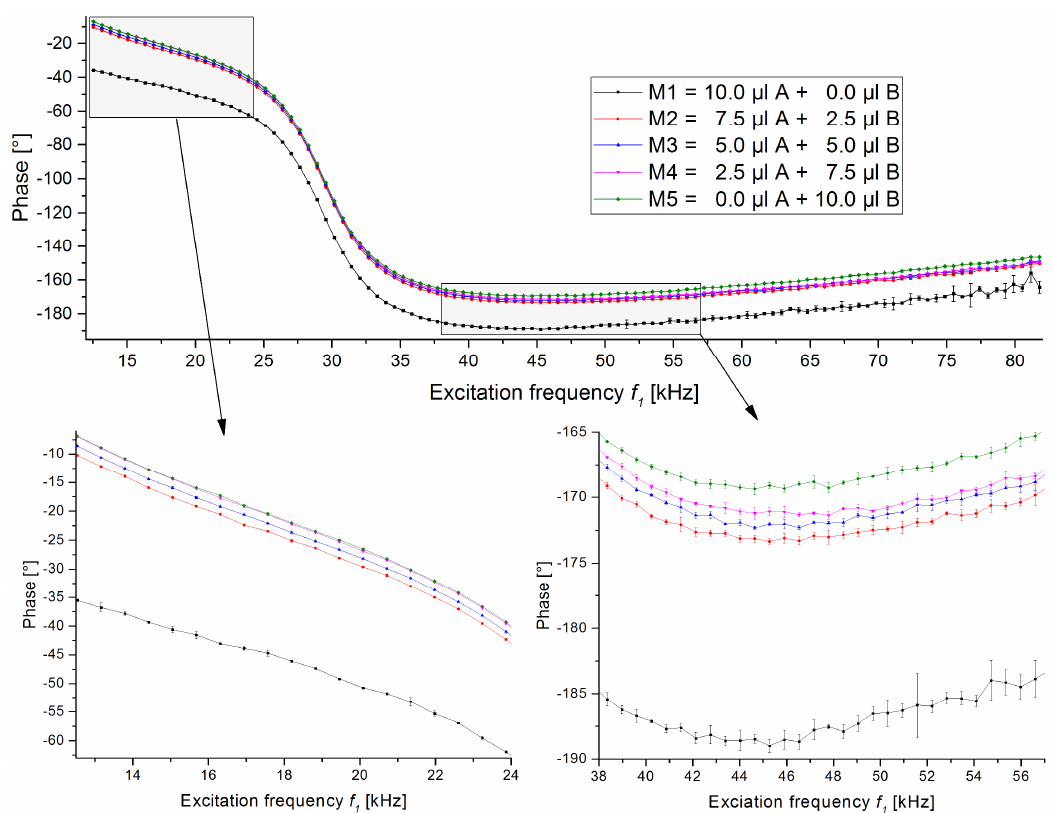
Figure 5. Phase traces of excitation frequency f 1 scans of 5 different samples containing different ratios of two superparamagnetic beads (see Table 2). The total bead solution was always 10 µL in 400 µL of distilled water. The complete trace is shown in the top, while in the two bottom diagrams, the low frequency and the intermediate frequency areas are magnified. For each excitation frequency, the mean value and the standard deviation of the frequency mixing signal at f 1 + 2 · f 2 are shown. In the bottom left graph, the traces of M4 and M5 overlap.